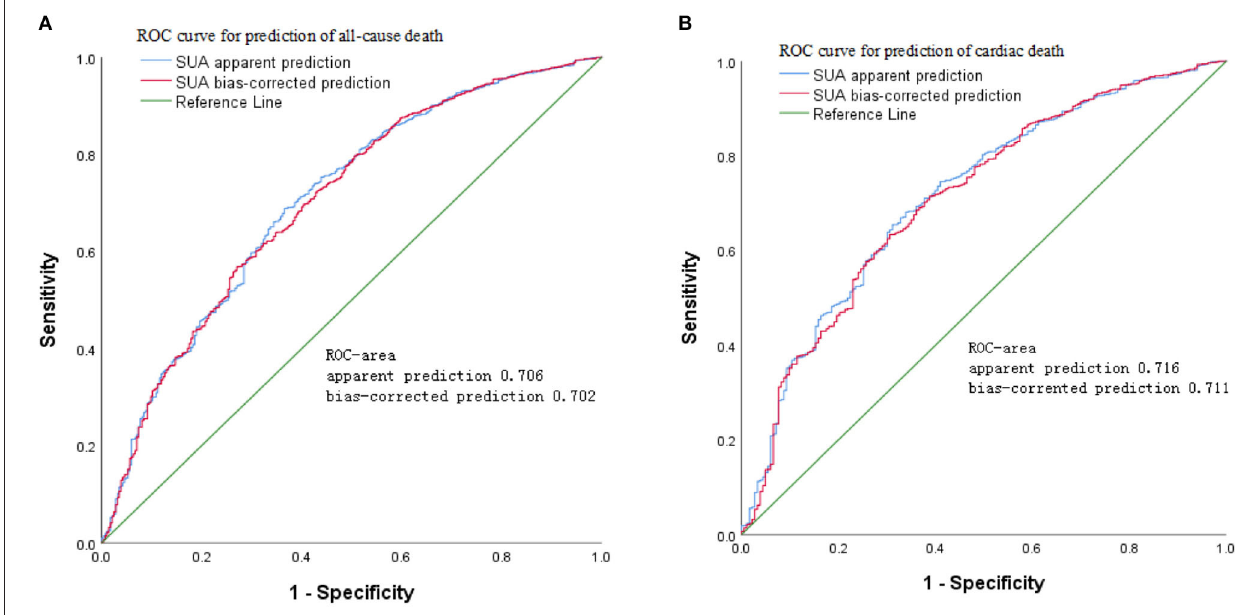
FIGURE 4 | Age- and sex-adjusted receiver operating characteristic (ROC) curves for predicting (A) all-cause mortality and (B) cardiovascular disease (CVD) mortality according to serum uric acid (SUA) in the cohort study during 6-year follow-up.